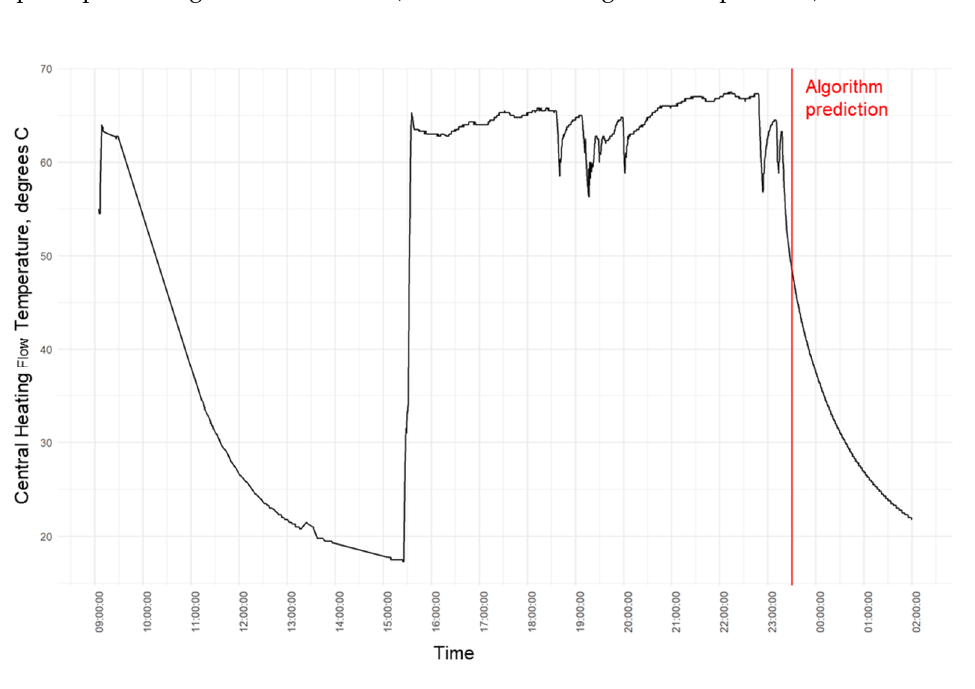
Figure A2. Comparison of the algorithm’s output to the ground truth for IDEAL home no. 137. Heating operation algorithm incorrectly predicts time of final heating switch off.